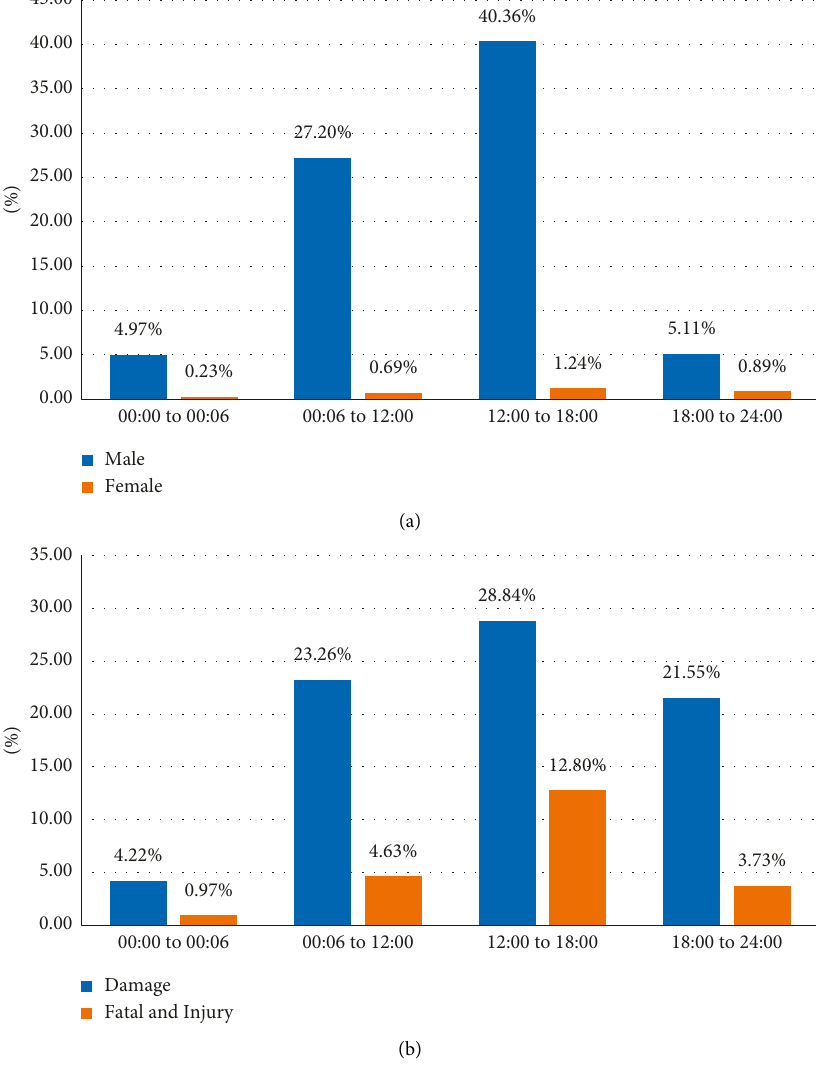
Figure 2: Statistics of vehicle accidents based on accident time: (a) gender of the driver and (b) severity of